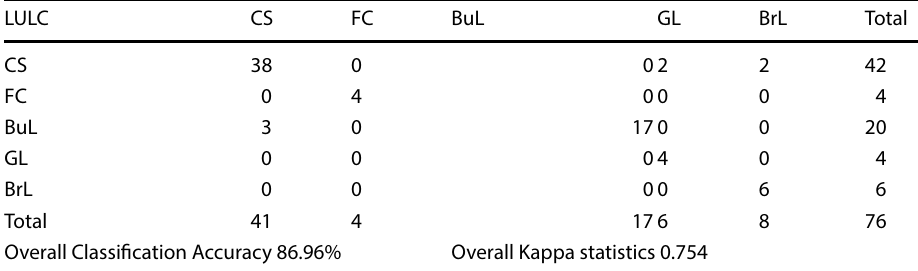
Table 4 Accuracy assessment of LULC classification,